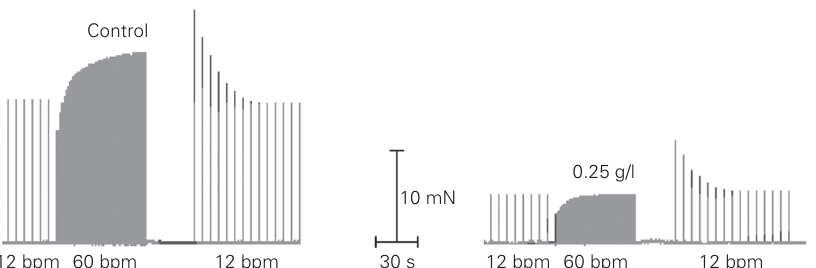
C).Figure 5. Cholinergic receptor involvement in the atrial effect of Psidium guajava extracts. The acetic acid fraction (AF, 10, 20, 35, 50, 100, 150, 200, 300, 500, and 800 mg/l) of P. guajava was tested before and after cholin- ergic blockade with atropine sulfate (Atrop, 1.5 mM, 20 min). The efficacy of the cholin- ergic blockade was confirmed by adding ace- tylcholine (ACh, 0.3 µM) to the organ bath before and after atropine sulfate. In the pres- ence of cholinergic receptor block, the acetic acid fraction of P. guajava (same concentra- tions as used previously) did not reduce the atrial inotropism. Similar results were ob- served in 7 paced hearts (2 Hz, 100 V, 0.5 ms, 27 ± 0.1 (cid:1) C; horizontal bars: 10 min; vertical bar: 5